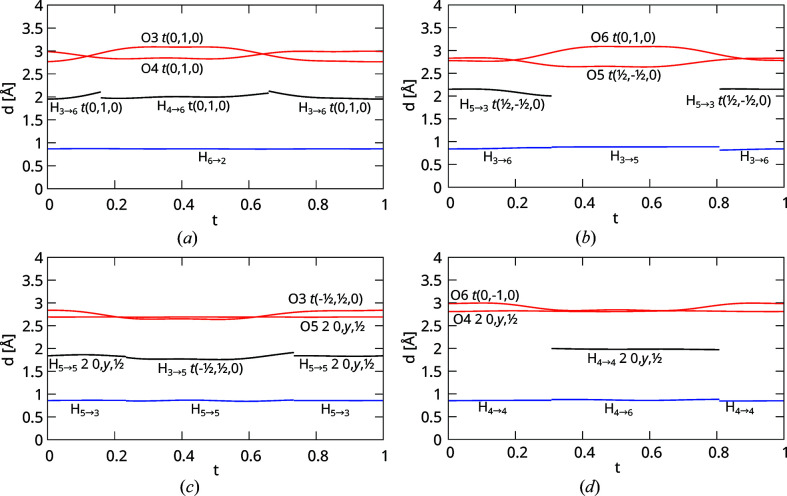

t-plot of (red) O—O, (blue) O—H and (black) H⋯O distances of (a) O6, (b) O3, (c) O5 and (d) O6.